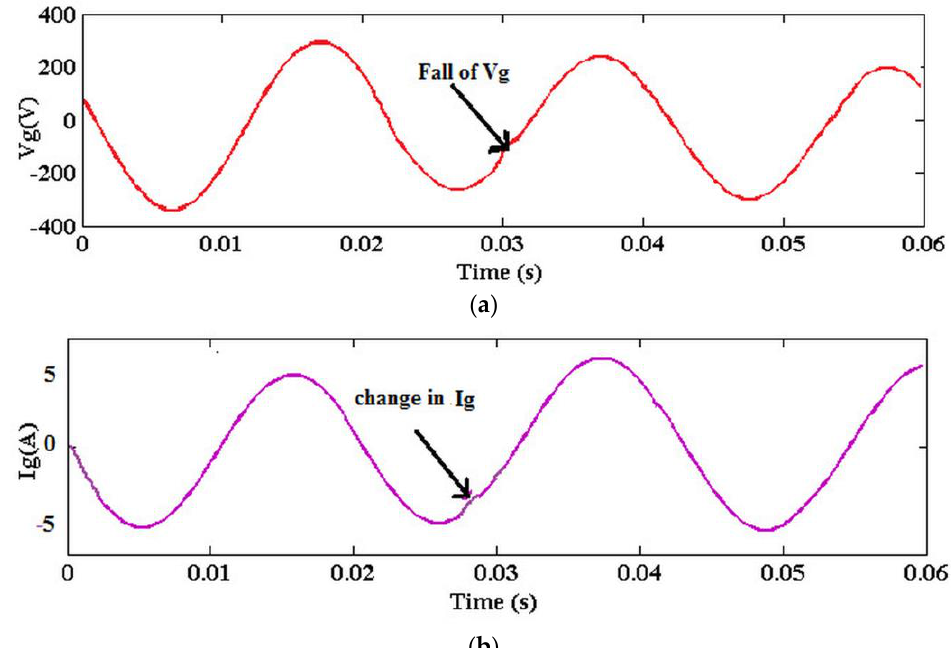
Figure 19. Waveform analysis of nine-level inverter ( a ). Grid voltage and ( b ). Grid current.